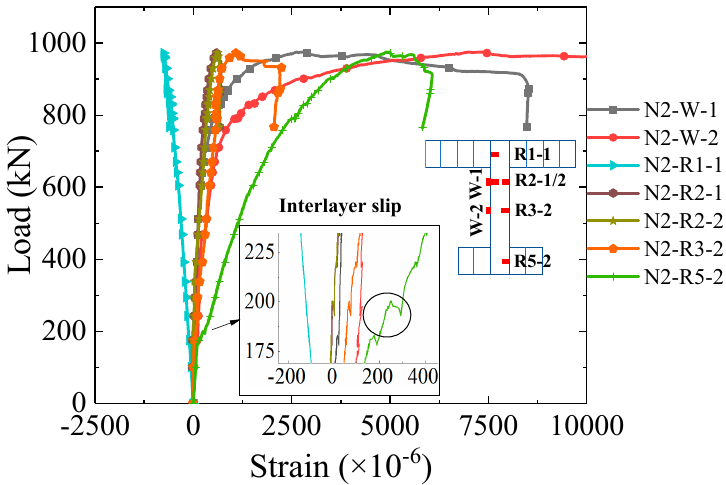
Figure 11. Load–strain curves of the reinforcing bars at mid-span. The sectional strain distribution under different load stages at mid-span is shown in Figure 12. The sectional strain distribution up to 100 kN matched well with the plane section assumption from the elastic beam theory. The strain at the bottom of the girder had an uprush at the load stage of 200 kN due to the steel–concrete interlayer slip. The phenomenon of interlayer slip matched with the test observation and the strain monitoring. With the increase of the load, the interlayer slip gradually stretched upward.